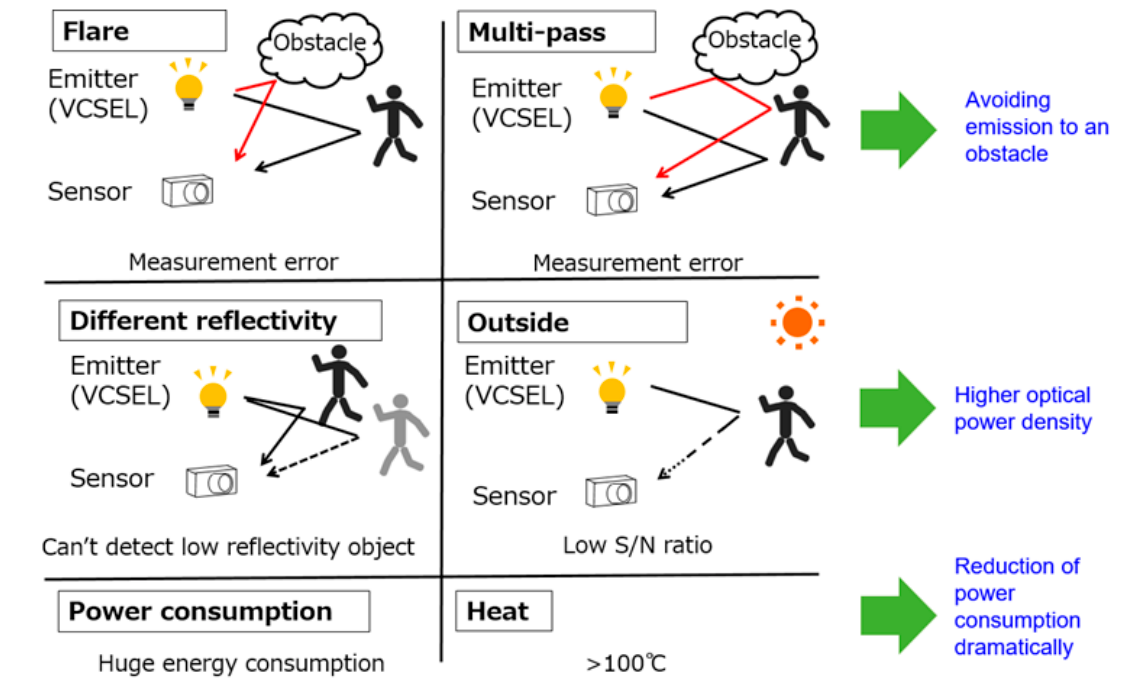
Figure 1. Problems associated with ToF systems .